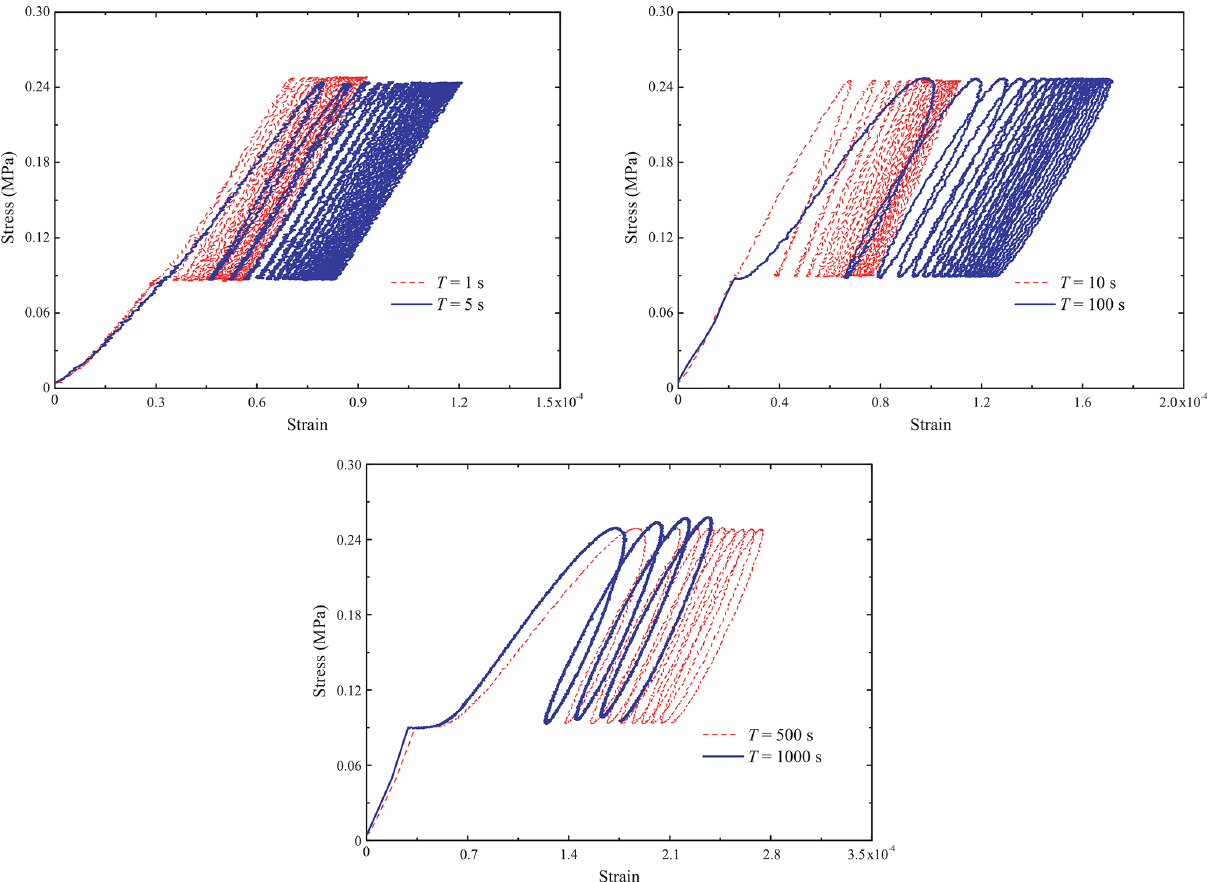
Figure 9. Stress–strain curves of specimen Dry-5ppt-1 tested with stresses varying from 0.08 to 0.25MPa and with a temperature of − 10 ◦ C.